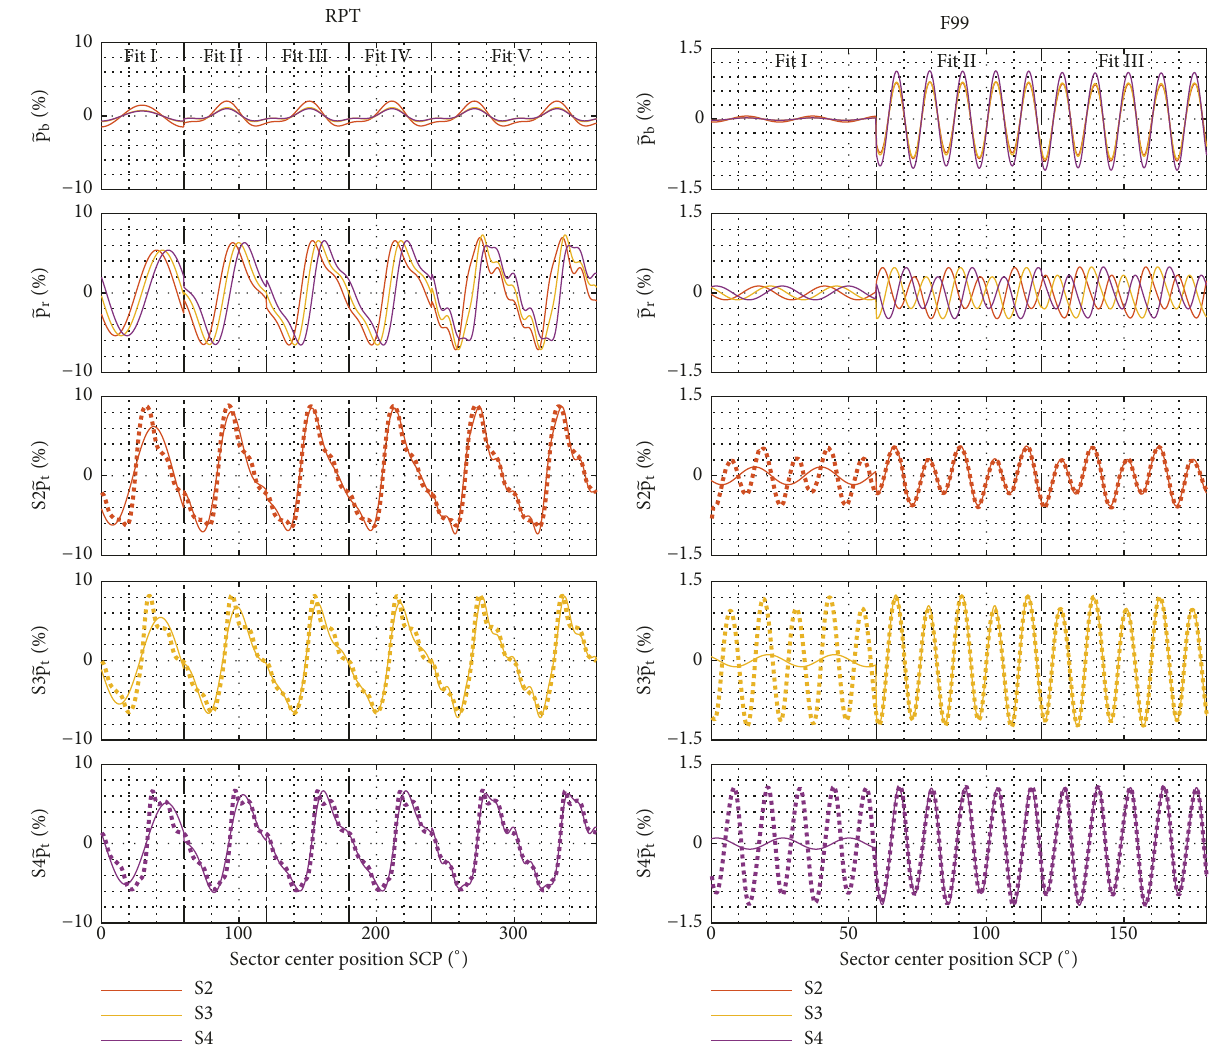
Figure 9: The fitting results. The results are divided into the throttling effect, the runnerpressure effect, and the total pressure in eachlocation